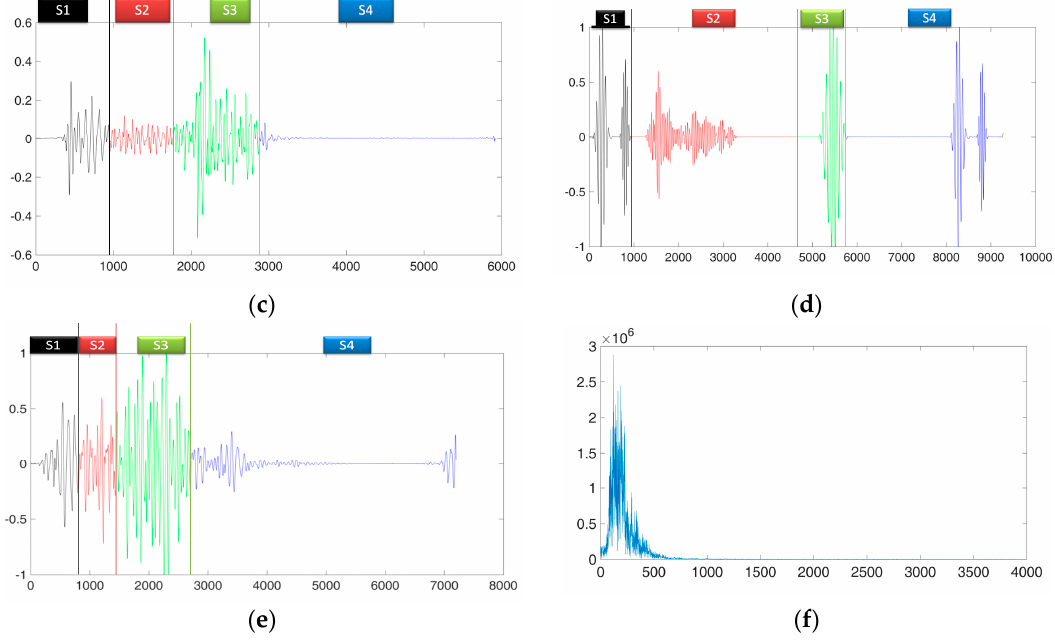
Figure 1. ( a ) A normal heart sound signal; ( b ) Murmur in systole (MVP); ( c ) Mitral Regurgitation (MR); ( d ) Mitral Stenosis (MS); ( e ) Aortic Stenosis (AS); ( f ) Spectrum of a PCG signal.